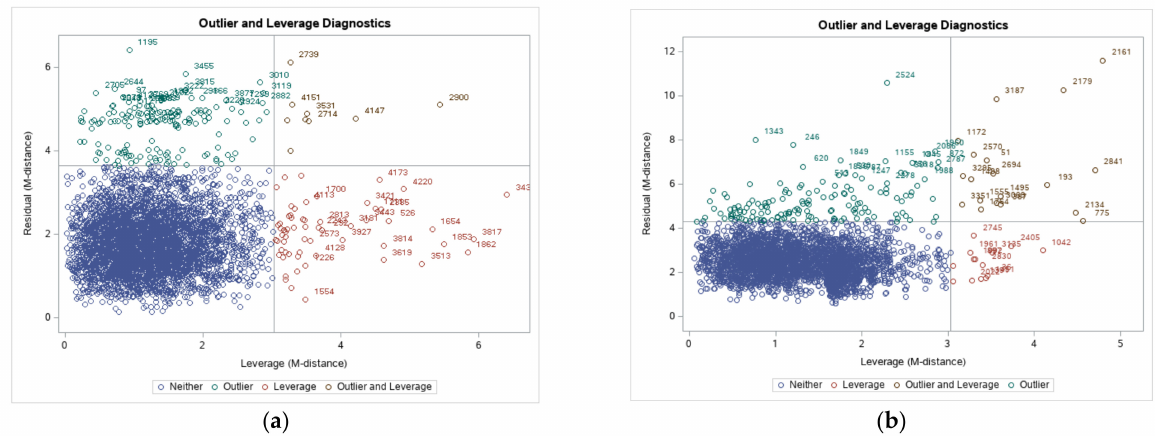
Figure 4. Outliers ( a ) pre-trial data set and ( b ) post-trial data set. Probability graphs are displayed to assess whether a data set was approximately normally distributed. The data were plotted against a theoretical normal distribution so that the points should have formed a straight line. Departures from it indicate departures from normality that were more evident for the post-trial data set (as in Figures 5 and 6). The distributions of the residuals are provided in Figure